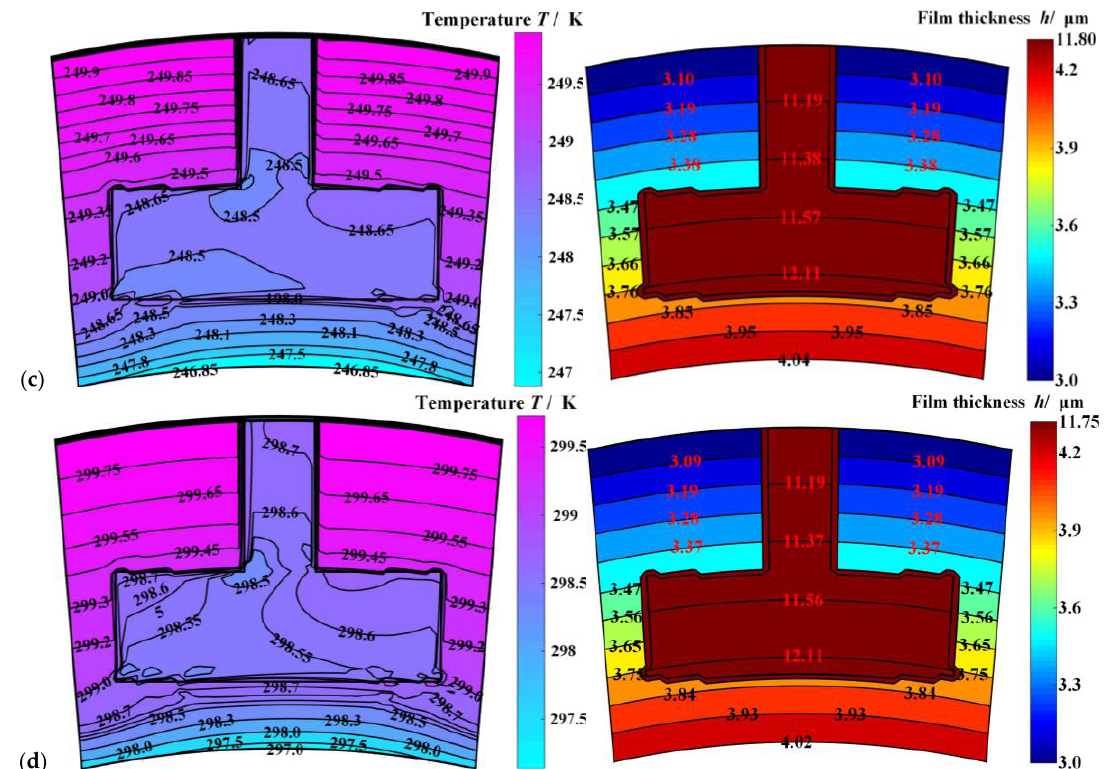
Figure 4. The film temperature fields and film thickness distribution of the sealing film under different inlet ambient temperatures ( h 0 = 3.0 μm, ω = 20,000 r·min −1 , p o = 5.0 MPa,). Note: ( a ) T o = 150 K; ( b ) T o = 200 K; ( c ) T o = 250 K; ( d ) T o = 300 K.